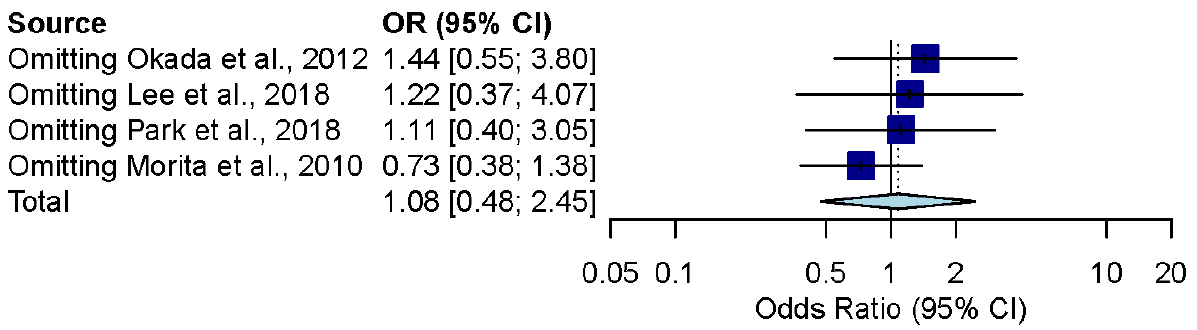
Figure 5. Influence analysis for the overall effect of diuretics alone and combination therapy in ALHL patients [9–11,21]. 3.5. Trial Sequential Analysis The trial sequential analysis (TSA) revealed a nonsignificant difference when com- paring combination therapy and steroids-alone therapy or diuretics-alone treatment, since the RIS was reached, and the Z-curve did not surpass both the traditional significance